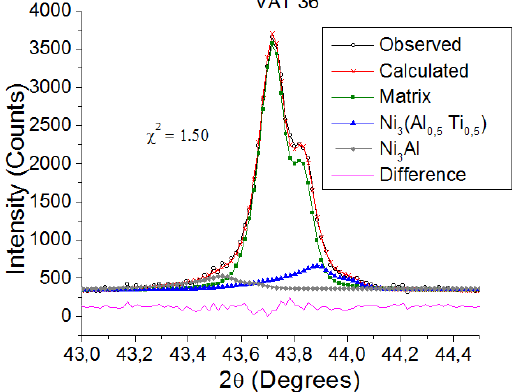
Figure 6. Rietveld refinement carried out at 2θ = 44° for the alloy VAT 36.